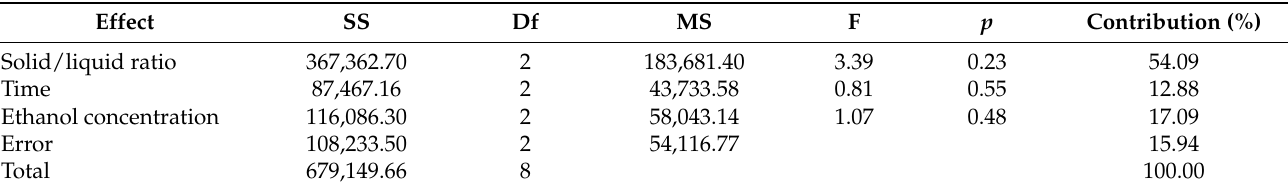
Table 2. Analysis of variance.